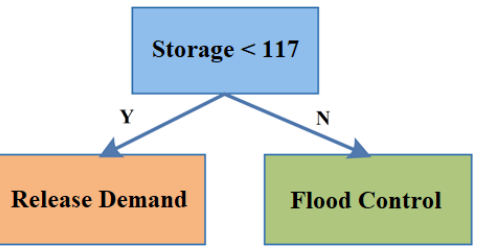
Figure 17. The optimized policy tree for the base scenario .